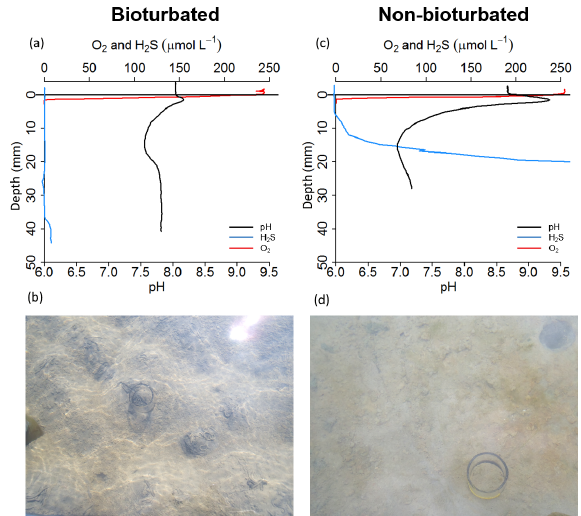
Figure 9. Activity of cable bacteria in mesocosm experiments with two treatments: bioturbated (sediment with the addition of lug- worms) and non-bioturbated (control sediment without lugworm addition). (a) Microsensor depth profiles reveal an active cable bac- teria population in the bioturbated mesocosm. (b) Surface appear- ance of the bioturbated sediment showing faecal casts of lugworms. The coring location for microsensor profiling is indicated with the core liner. (c) Geochemical fingerprint in non-bioturbated sediment shows strong cable bacteria activity. (d) Surface appearance of the non-bioturbated sediment with core location for microsensor profil-